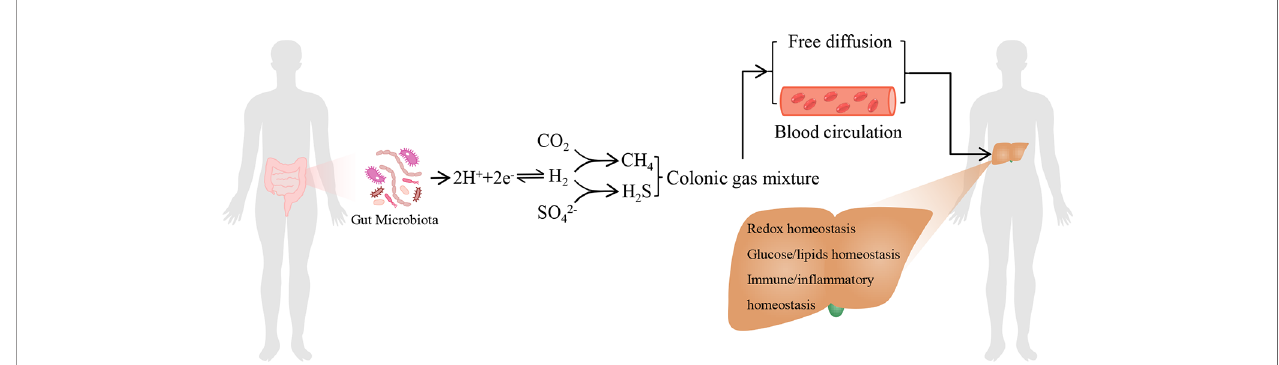
FIGURE 1 | The model of endogenous H 2 in modulating liver homeostasis. The endogenous H 2 is primarily produced by hydrogenase-expressing fermentative bacteria in the gastrointestinal tract. Moreover, H 2 S and CH 4 are by-products of H 2 metabolism derived from sulphate-reducing bacteria and methanogenic bacteria, respectively. It should be noticed that hepatocyte can also produce H 2 S and CH 4 . The colonic gas mixture, including H 2, H 2 S, CH 4 , and other bioactive gas molecules produced by gut microbiota, can arrive at the liver by free diffusion or by blood circulation. These gas molecules may in fl uence hepatic redox homeostasis, glucose and lipids homeostasis, immune and in fl ammatory homeostasis, respectively, together by another one or more. Therefore, H 2 may act as a novel bridge between gut and liver, and play a central role among the colonic gas mixture in modulating liver